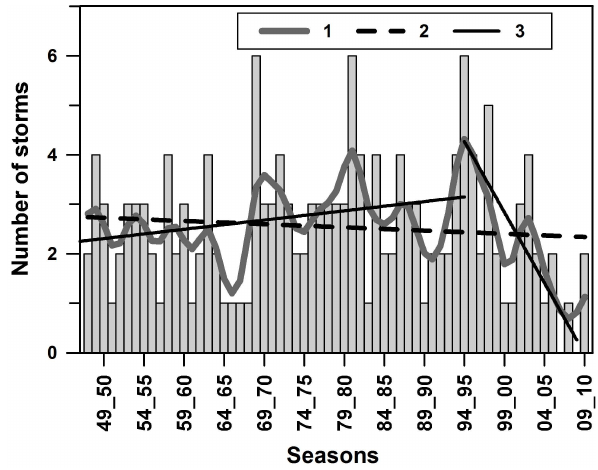
Fig. 4. Number of storms within storm seasons dur- ing 1948–2010: 1 – LPF approximation, 2 – global linear trend ( − 0.06 stormsdecade − 1 , R 2 = 0 . 008), 3 – local linear trends – upward (0.19 stormsdecade − 1 , R 2 = 0 . 04), downward (2.9stormsdecade − 1 , R 2 = 0 .